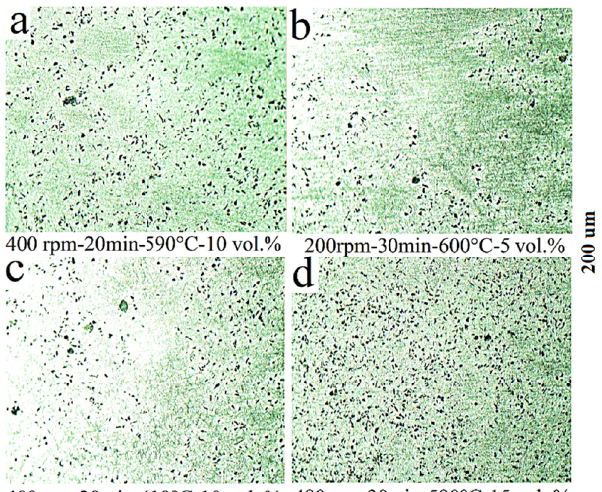
Fig. 6. Optical micrographs of the A356-SiC p composites fabricated by the different compocasting process parameters and SiC contents (a-c) confirmation tests and (d) at optimal